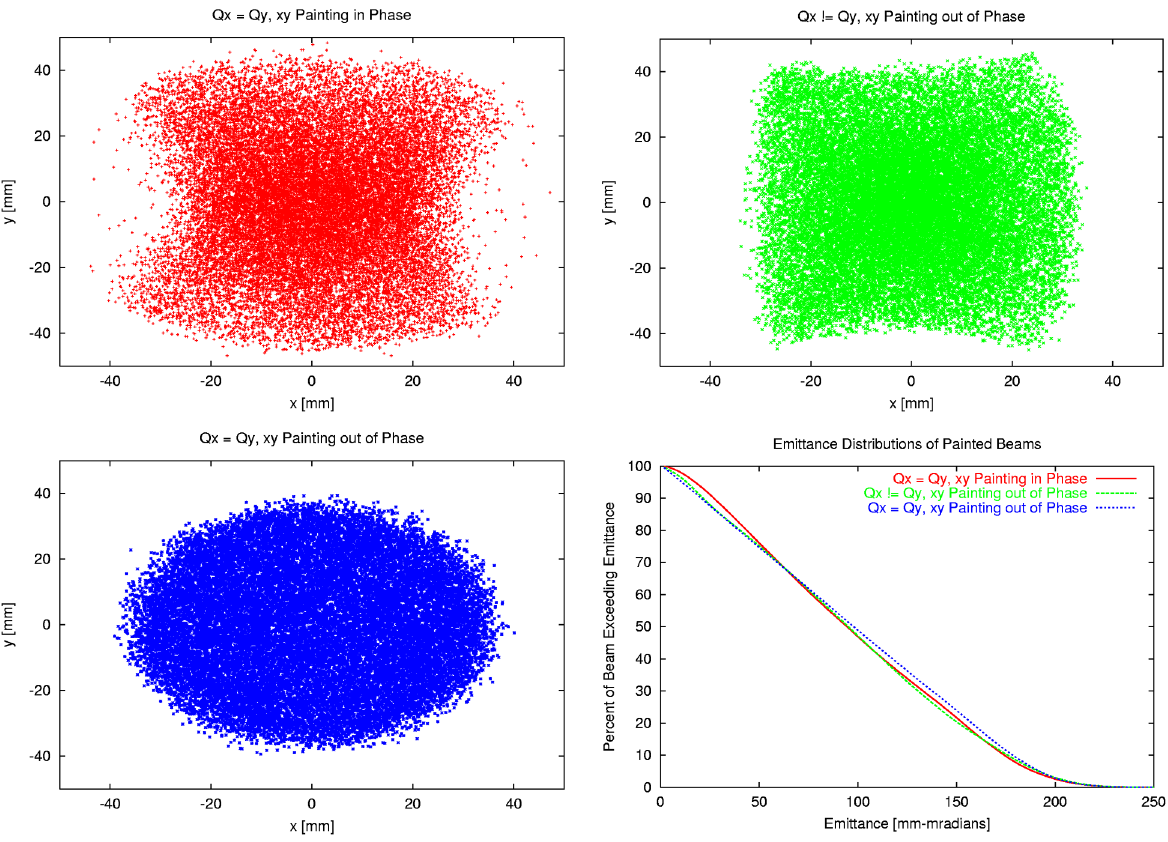
FIG. 2. (Color) Results of painting with linearly increasing emittance, as indicated by linearly decreasing emittance distributions, for (red distribution) equal tunes and same horizontal and vertical betatron phases, (green distribution) unequal tunes and 90 (cid:17) betatron phase separation, and (blue distribution) equal tunes and 90 (cid:17) betatron phase